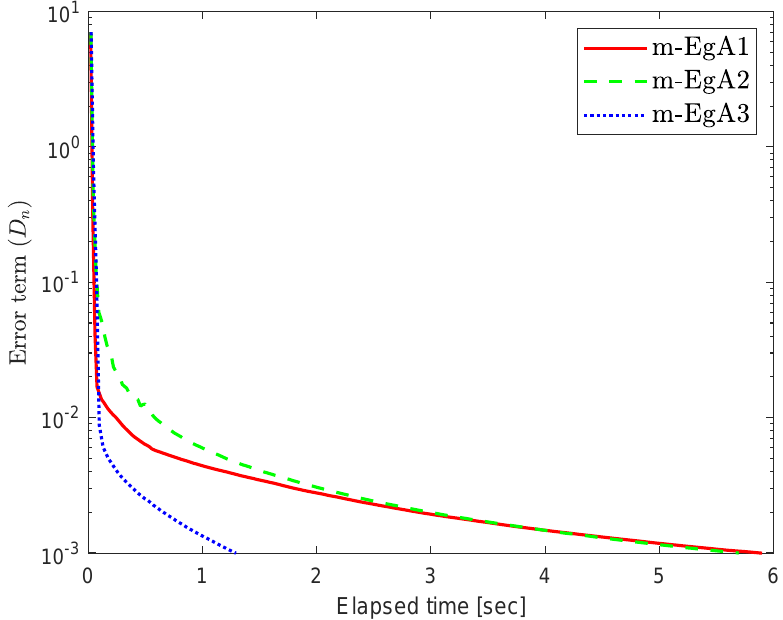
Figure 8. Numerical behaviour of Algorithm 1 compared to Algorithm 1 in [30] and Algorithm 2 in [30] for Example 1, when m =